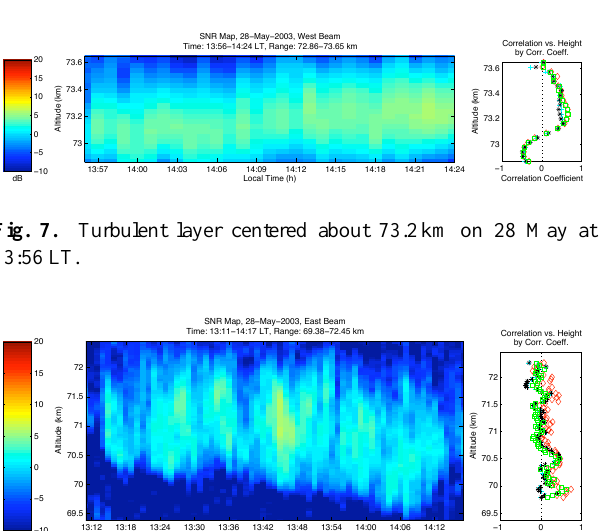
Fig. 6. Thin layer on May 27 (a) at 69 km, 13:00 LT and (b) at 67.4 67.4km, 14:00 LT. R. Sheth et al.: Radar study of mesospheric fine structure km, 14:00 LT.